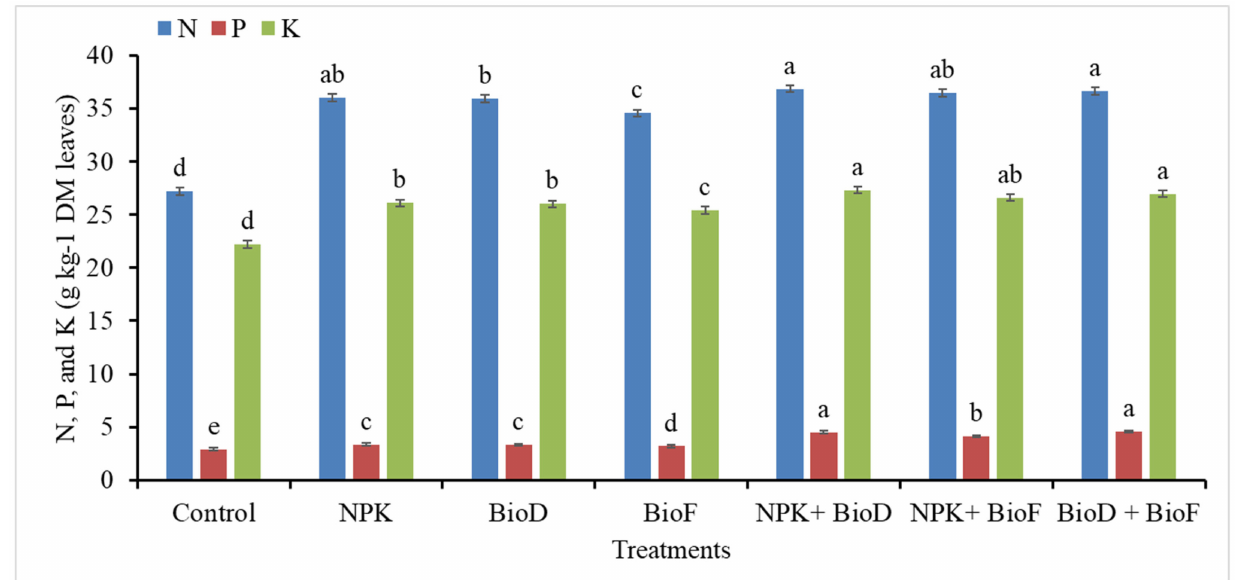
Figure 2. Effect of synthetic, organic, and bio-fertilizers on macro elements analysis of faba bean leaves. Columns with different letters significantly differed from each other as indicated by the Tukey test ( p ≤